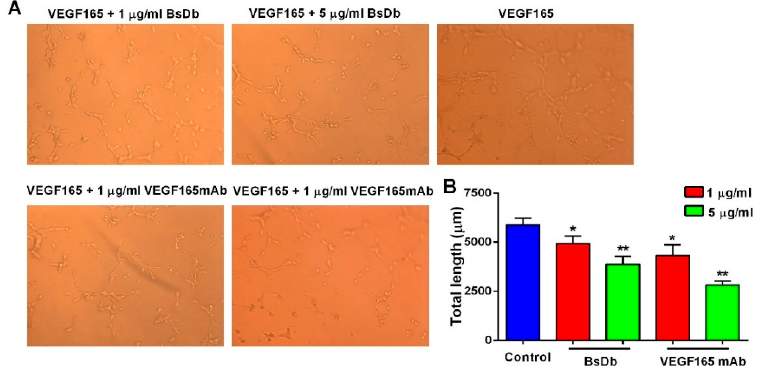
Figure 8. The recombinant BsDb inhibited tube formation of primary HUVECs. ( A ) HUVECs were seeded into 96-well plates that were coated with matrigel, then 100 ng/mL VEGF165 and various concentrations of BsDb or VEGF165 mAb were added to the 96-well plate, and the wells were photographed after incubation for 5 h at 37 °C (200×). ( B ) Quantification of the tube length by ImageJ software. The experiment was performed in triplicate and the mean values ± SD were shown. * p < 0.05 and ** p < 0.01 using a two-tailed students t-test versus the control group.